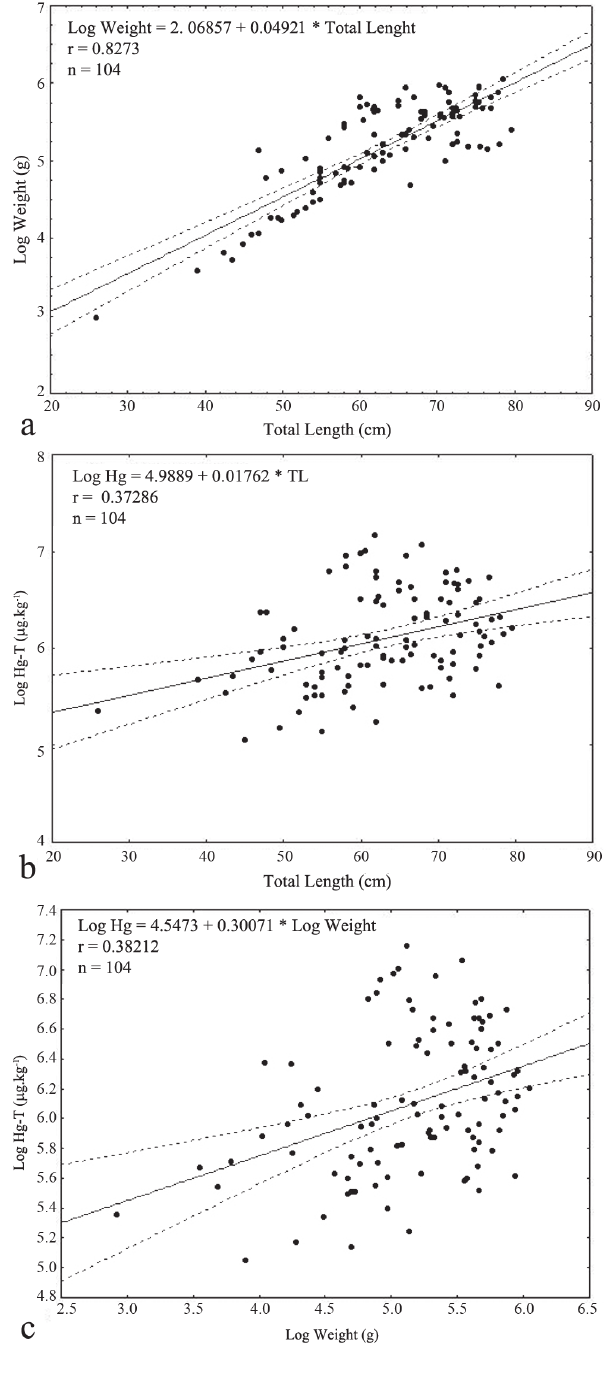
Fig. 4. Two-way ANOVA. a . Total length (cm); b . Weight (g); c . Log (mgHg-T.kg -1 in the muscle) considering seasons and months (1 = dry season 1 - November and December 2005, January 2006; 2 = end of the rainy season - August to October 2006; 3 = dry season 2 - November and December 2006, January